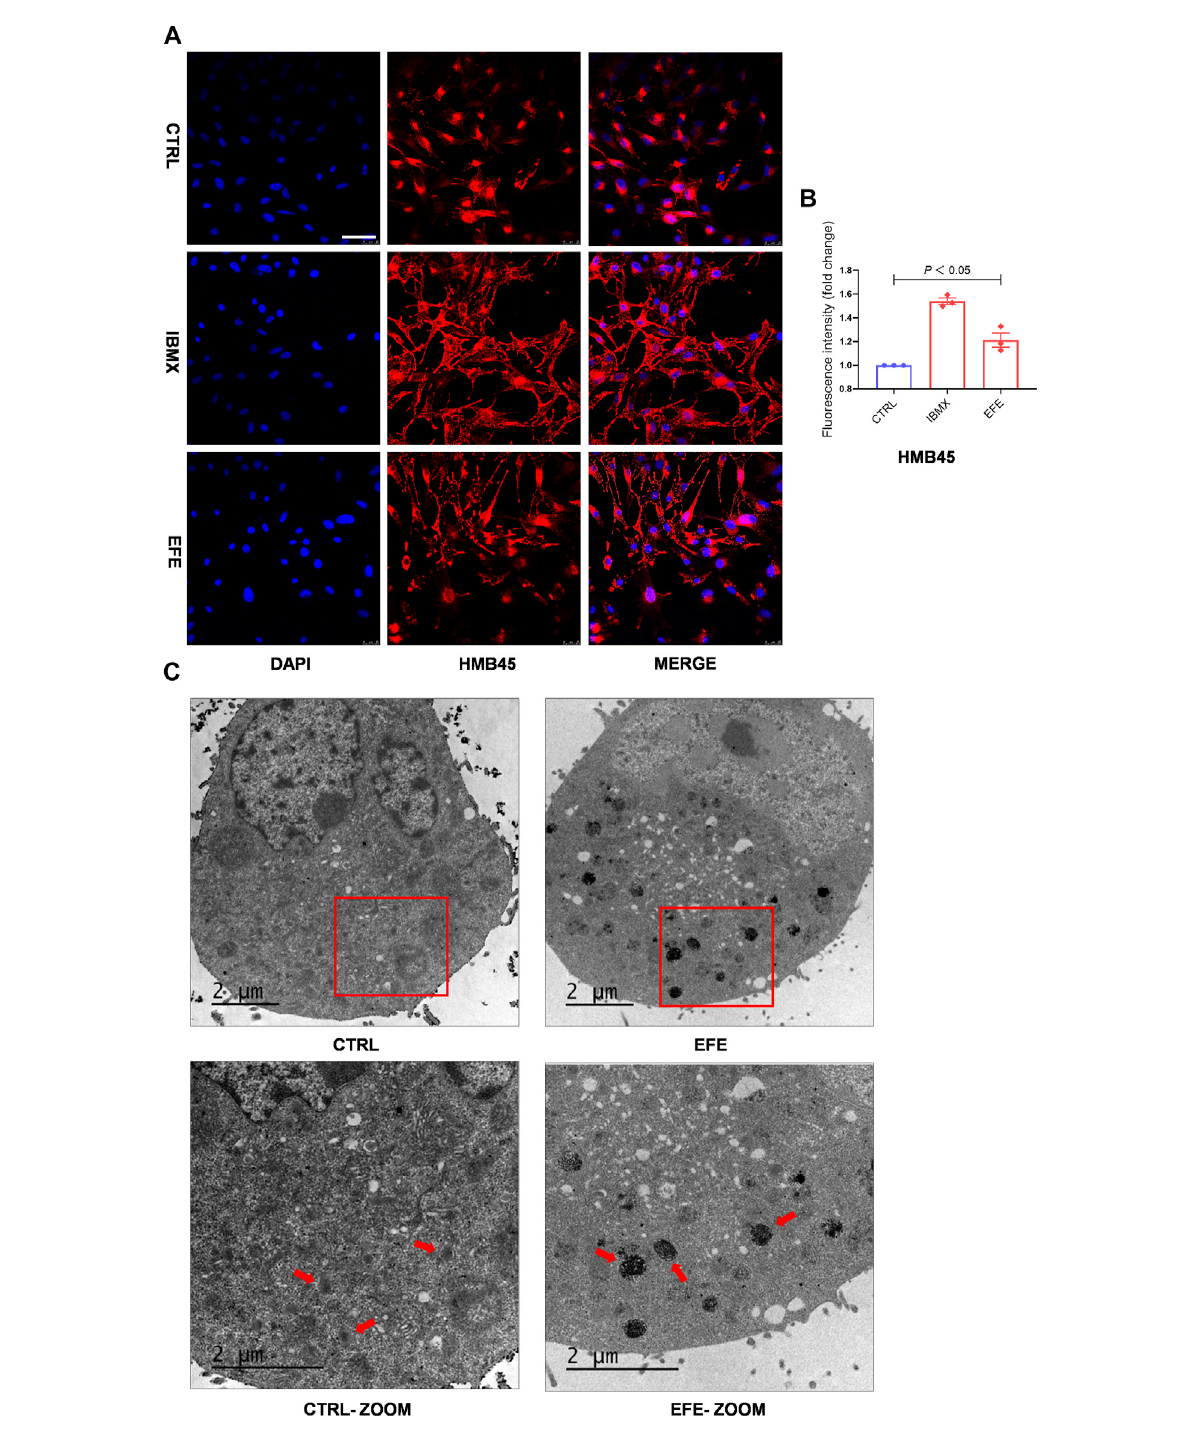
FIGURE 6 EFE raises melanosome number, promotes melanosome maturation/transferring in co-cultured melanocytes and keratinocytes to pigmentation. (A) Representative images of immuno fl uorescence staining in B16F10 cells (red: HMB45, blue: DAPI; IBMX-100 μ M, EFE-40 μ g/ml treated for 72 h; scale bar = 50 μ m); (B) fl uorescence intensity statistics for HMB45; (C) representative images of melanosome in B16F10 cell using transmission electron microscopy (CTRL, EFE: 6,000 ×; CTRL-ZOOM, EFE-ZOOM: 9900 ×; scale bar = 2 μ m). For graphical representation, data are presented as mean ± SEM ( n ≥ 3 in each group), p < 0.05, p < 0.01, and p < 0.001 vs. CTRL are considered signi fi cant. Representative image from three independent experiments is